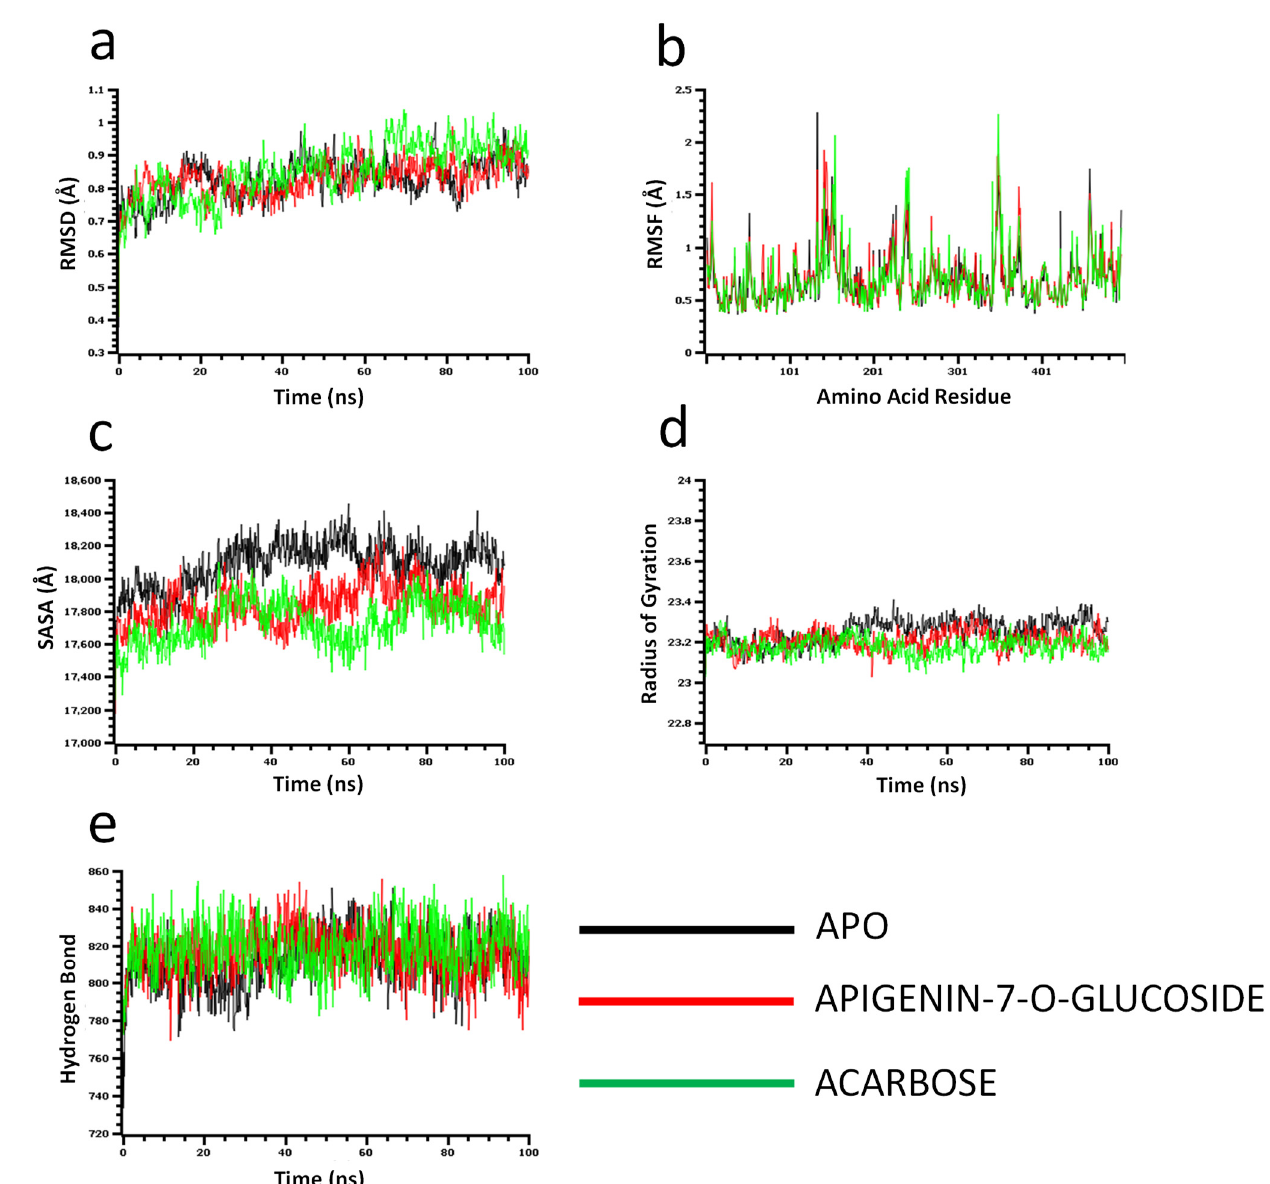
Figure 4. Molecular dynamics simulation for alpha-amylase. Analysis of ( a ) RMSD (Root Mean Square Deviation); ( b ) RMSF (Root Mean Square Fluctuations); ( c ) SASA (Solvent Accessible Surface Area) ( d ) Rg (Radius of Gyration); and ( e ) Binding free energy.